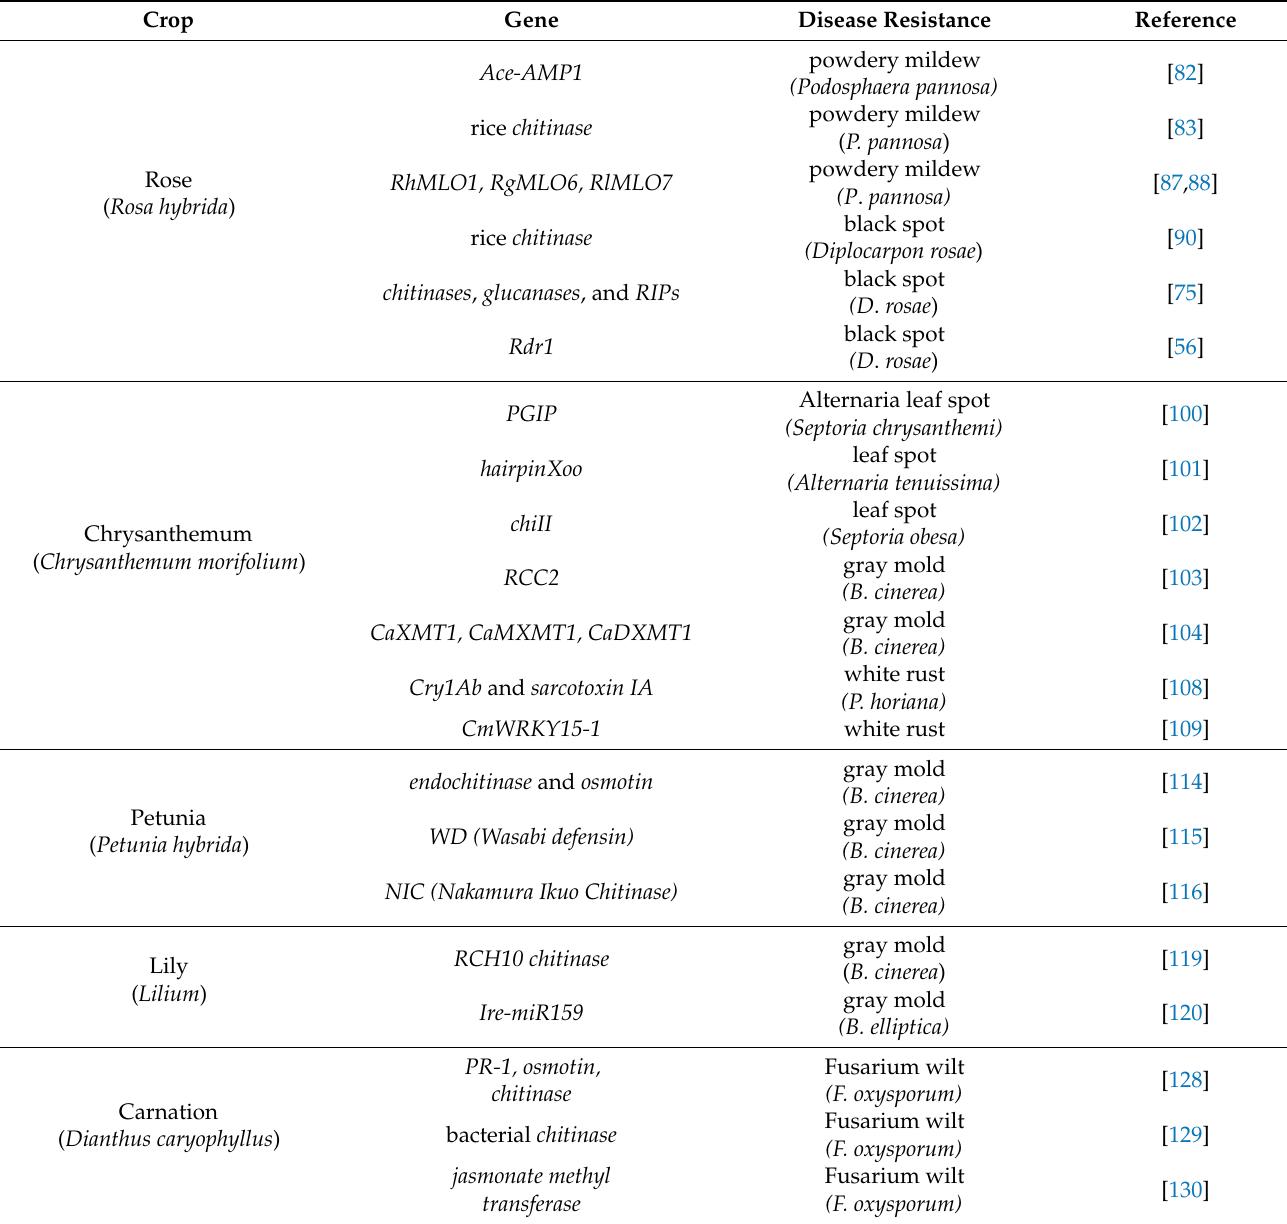
Table 2. Recent advances in the genetic engineering of various ornamental crops for fungal disease resistance.